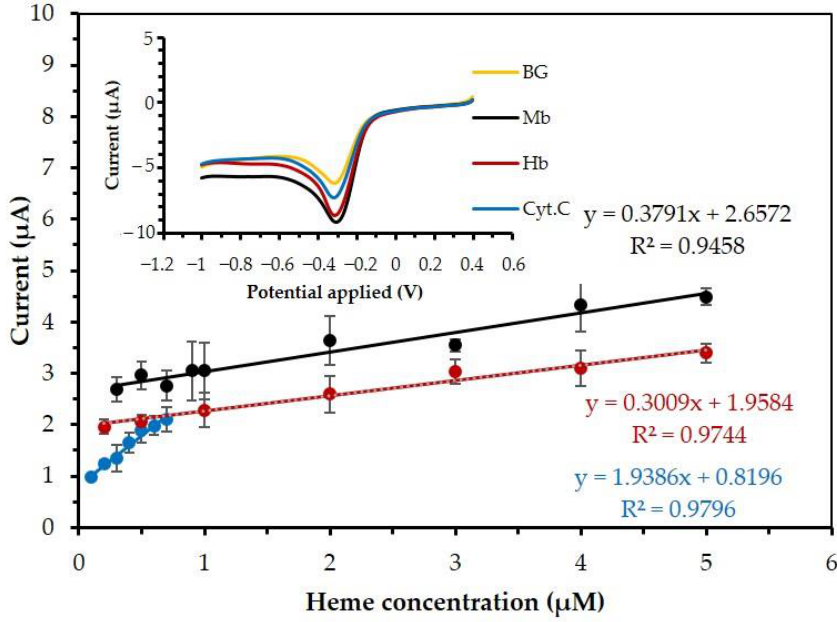
Figure 13. The current response of Hb (red), Mb (black), and Cyt. C (blue) vs. concentration of hemeproteins. The scan rate was used at 20 mV/s. Inset illustrates the LSV of the MB/GP-modified electrode in 0.1 M buffer solution containing 0.1 M KCl in the presence of 0.5 µ M of each of Hb (red), Mb (black), and Cyt. C (blue).